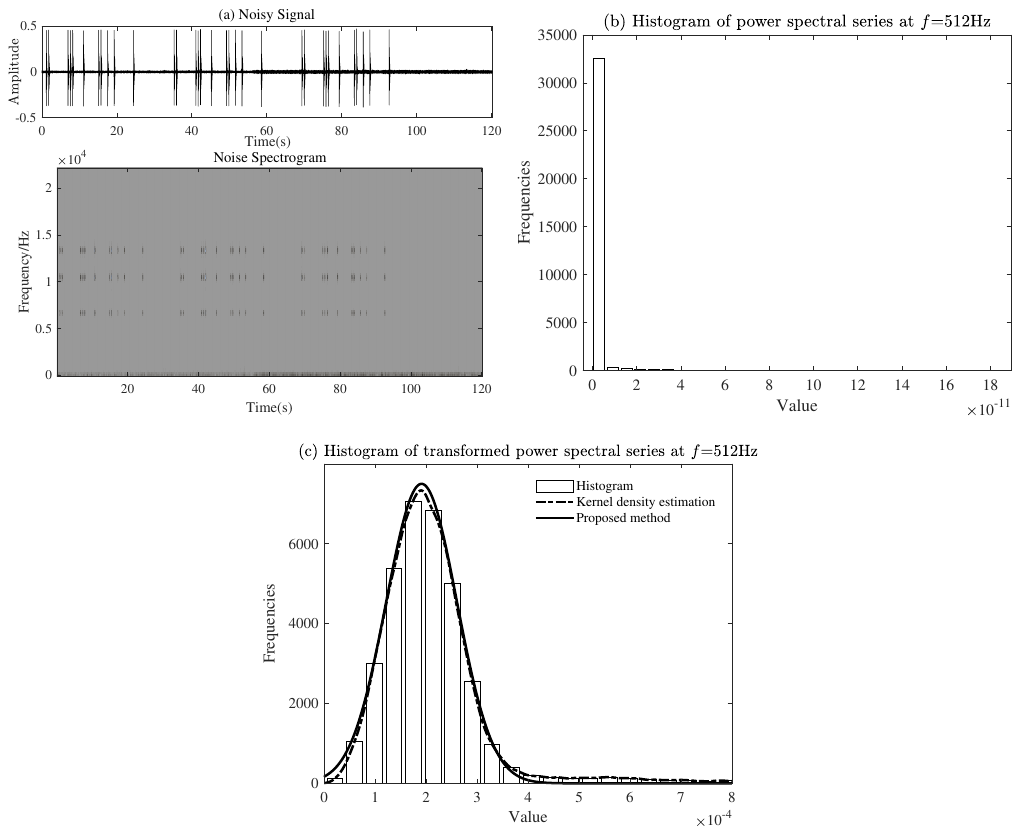
Figure 10. ( a ) example of a noisy signal for analysis and the corresponding spectrogram; ( b ) histogram of the power spectrum series of the noisy signal at f = 512 Hz; ( c ) histogram of the transformed power spectrum series of the noisy signal at f = 512